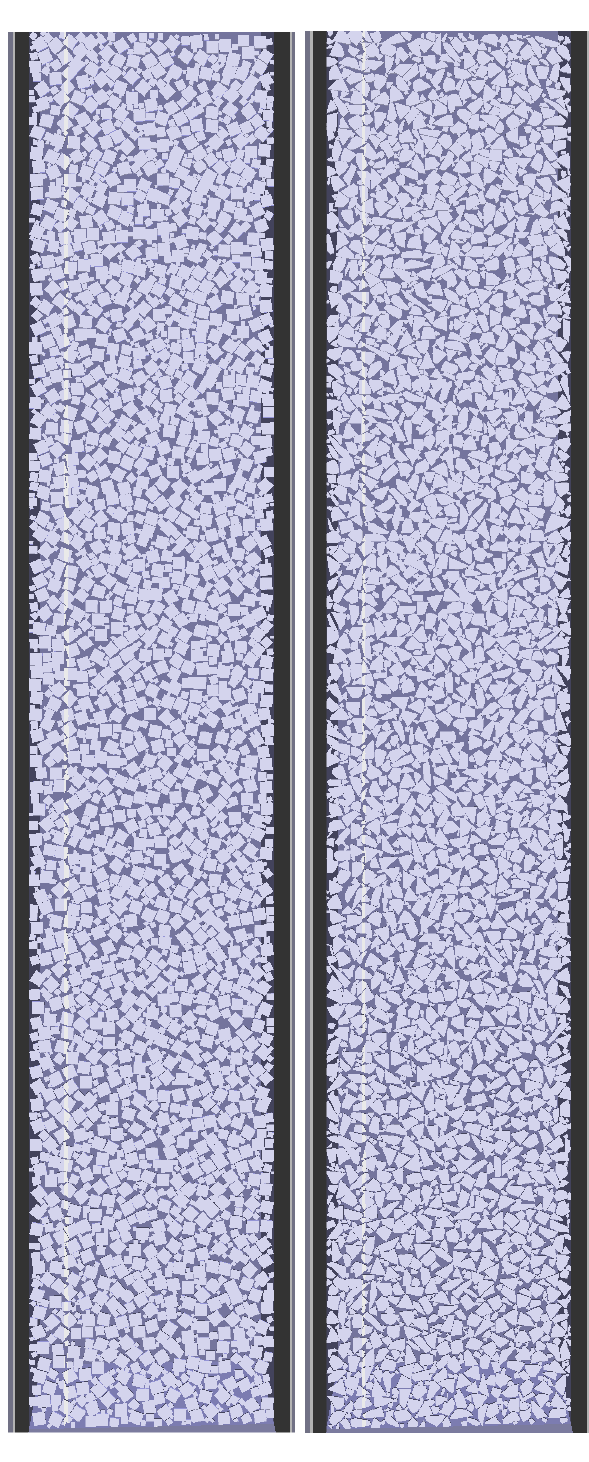
Figure 15: Two different 10 × 57 m ice fields gener- ated by the software: rectangular (left) and polygonal